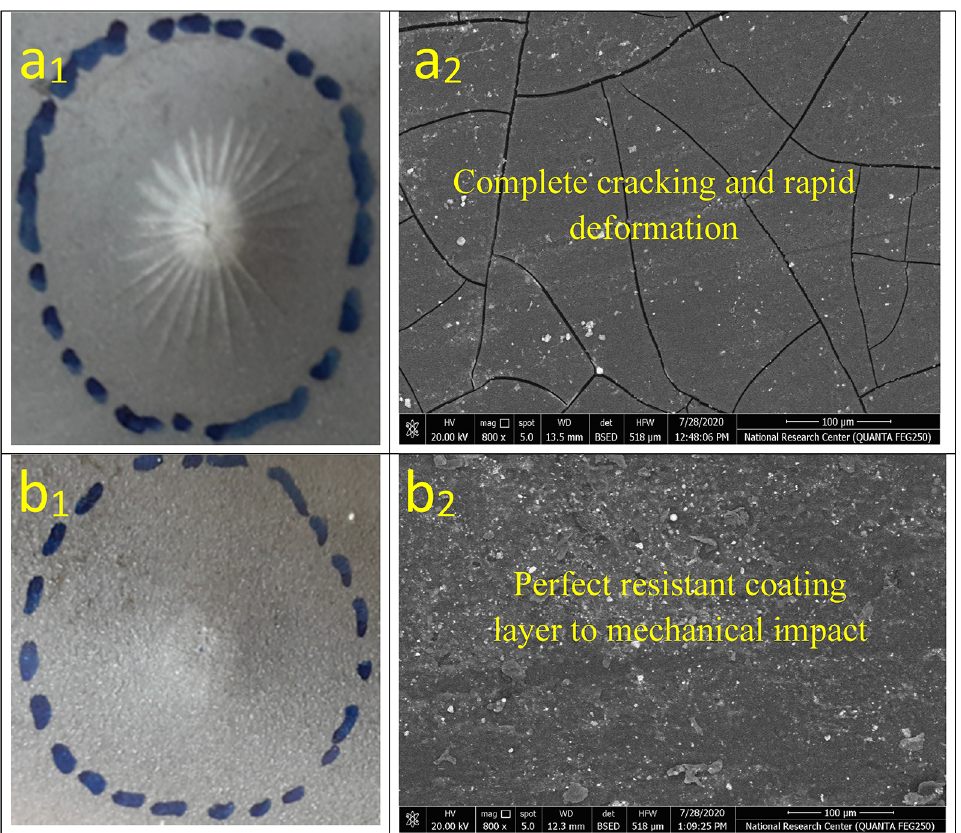
Figure 13. Impact (resistance to rapid deformation) test for the investigated coatings ( a 1 ) Photographic image of blank epoxy, ( a 2 ) SEM image of blank epoxy, ( b 1 ) Photographic image of PA-DGEBA/MC-Cu coating and ( b 2 ) SEM image of PA-DGEBA/MC-Cu